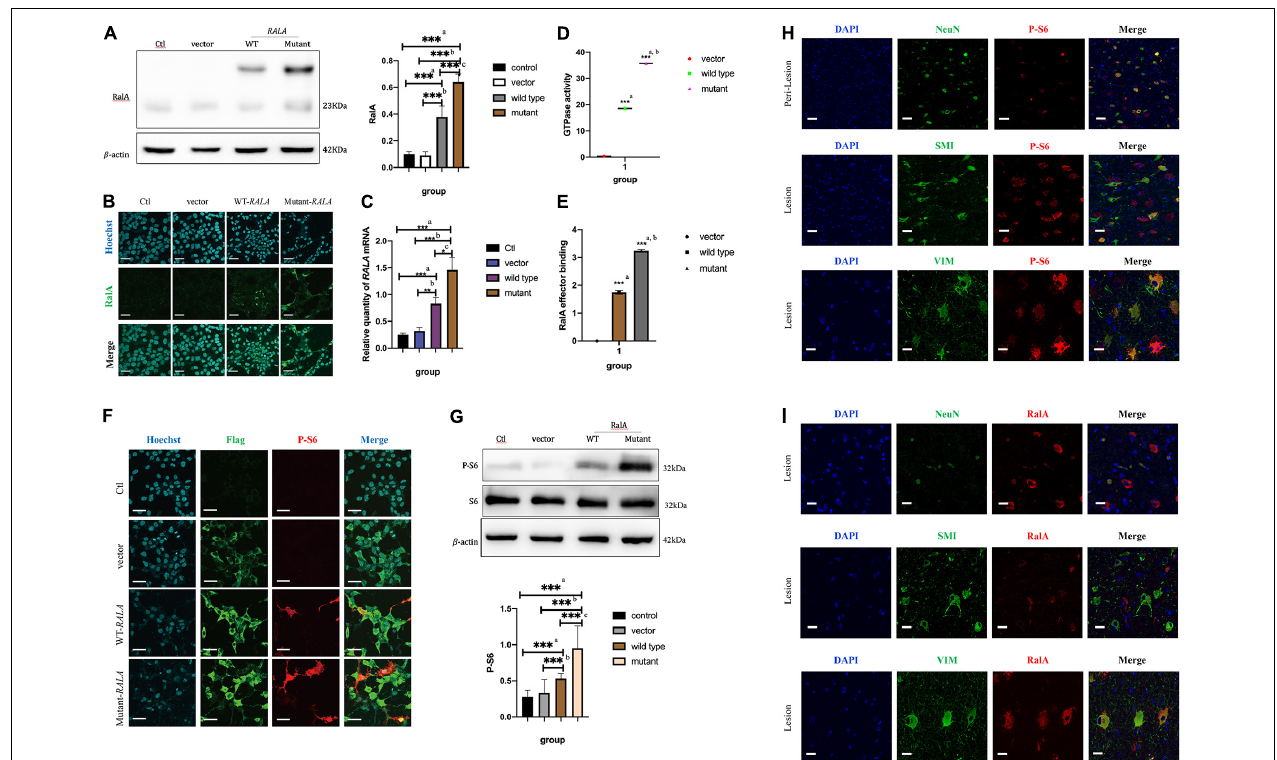
FIGURE 3 | RALA c.G482A increases the expression of RalA and promotes mTOR pathway overactivation. (A) Expression of RalA protein between different groups after RALA c.G482A transfection. Ctl, control; WT, wild type of RALA ; a, compared with Ctl; b, compared with vector; c, compared with WT. n = 6; *** P < 0.001. (B) Immunofluorescence of RalA protein in different groups after RALA mutant transfection. (C) Changes of RALA mRNA expression in different groups. n = 4; * P < 0.05; ** P < 0.01; *** P < 0.001. (D) Detection of GTPase activity of RalA. a, compared with vector group; b, compared with wild type. n = 3; *** P < 0.001. (E) Downstream effector activation assay after RALA mutation. a, compared with vector group; b, compared with wild type. n = 3; *** P < 0.001. (F,G) Immunofluorescence staining and Western blotting showed the activation of the mTOR pathway. P-S6, phospho-S6 Ribosomal protein (Ser240/244), one of the typical markers of mTOR pathway activation. Bar = 100 µ m; magnification: 10 × 60. n = 6; *** P < 0.001. (H) Activation of mTOR pathway in brain tissue. NeuN, marker of neurons; SMI-311, marker of dysmorphic neurons; Vimentin (V9), marker of balloon cells. (I) Expression of RalA protein in brain tissue. Bar = 50 µ m; magnification: 10 ×